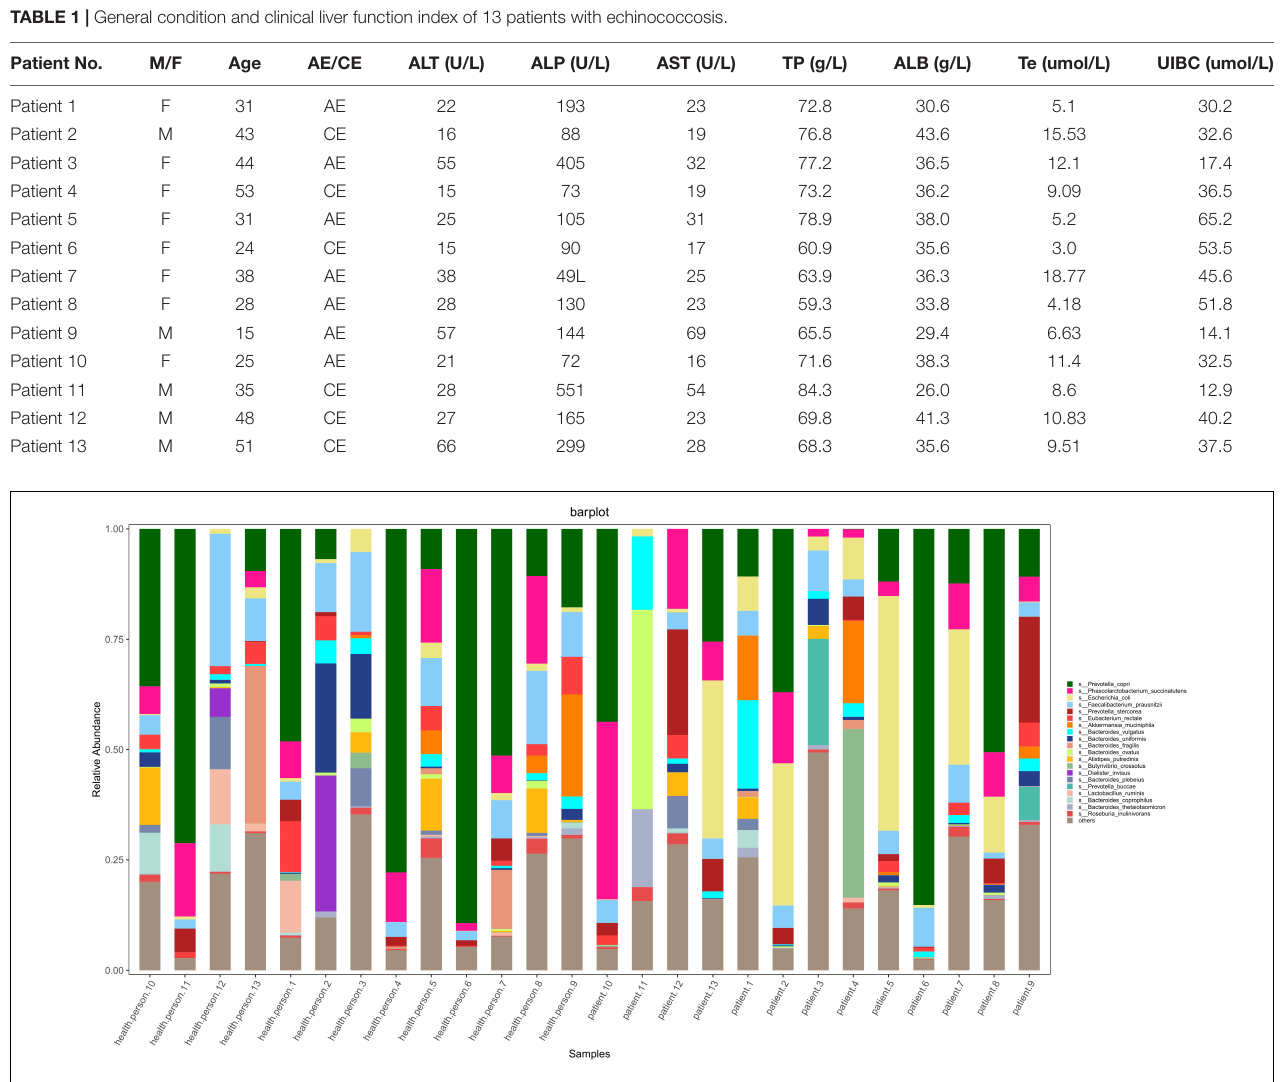
FIGURE 1 | Stacked bar diagram of species abundance for each sample at the level of the species including seven patients with alveolar echinococcosis (AE), six patients with cystic echinococcosis (CE), and 13 healthy individuals. They are: Prevotella copri, Phascolarctobacterium succinatutens, Escherichis